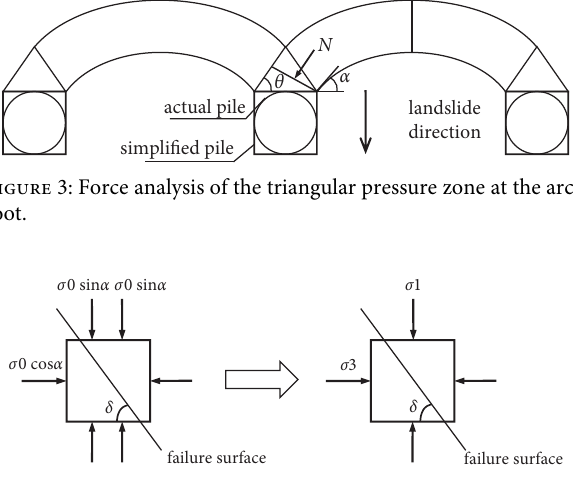
Figure 4: Stress distribution of microunits in the triangular pressure zone.